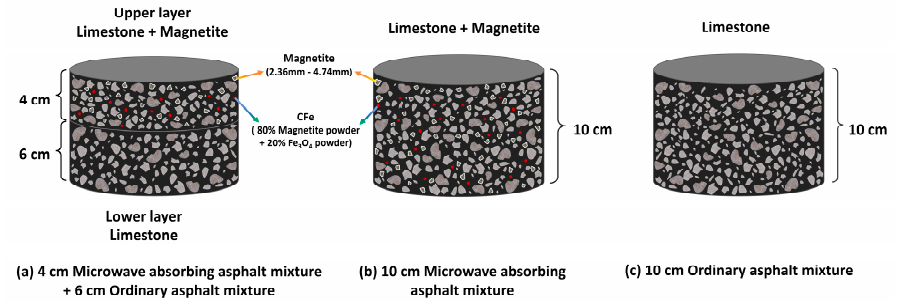
Figure 9. The schematic diagram for the Marshall specimens of the asphalt mixtures.